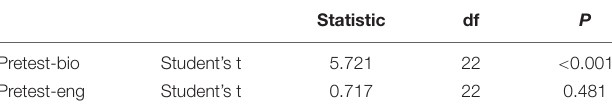
TABLE 3 | Independent samples t -test.